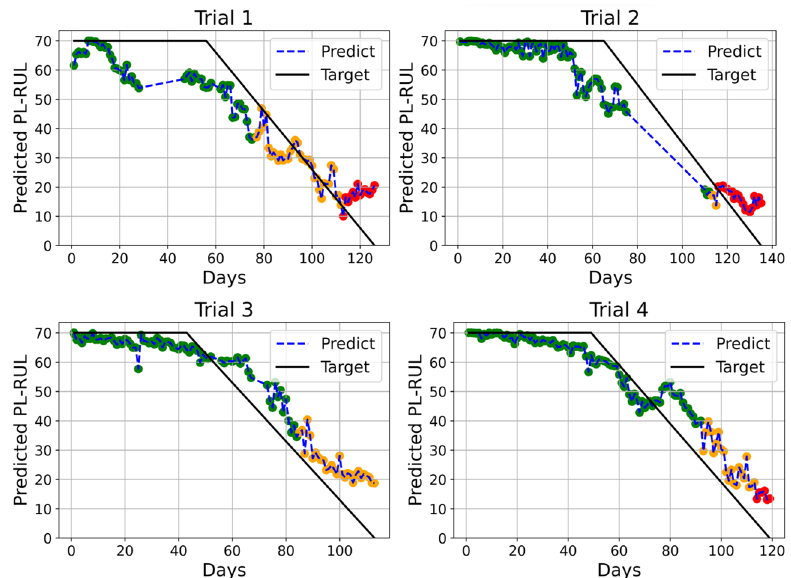
Figure 6. 4-Fold cross-validation results with T RUL = 70 days for trials 1 to 4 using A/C dataset, using Extremely randomized trees optimal Linearity setting (n_estimators = 100, max_depth = None, min_samples_leaf = 2, min_samples_split = 10).